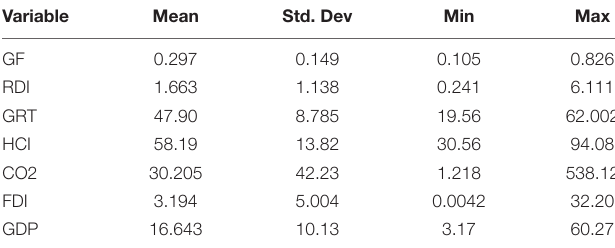
TABLE 2 | Descriptive statistical results of